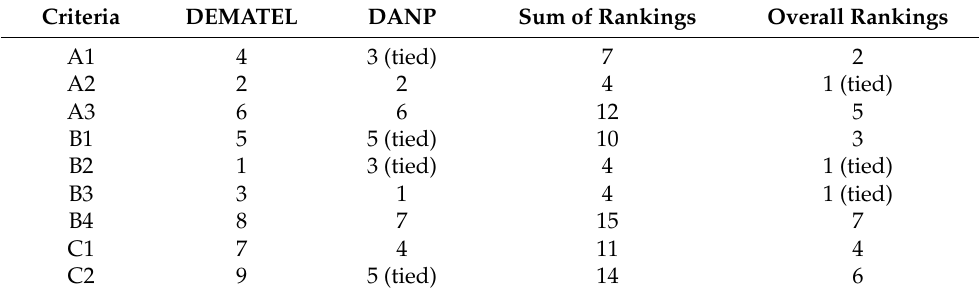
Table 9. Prominence